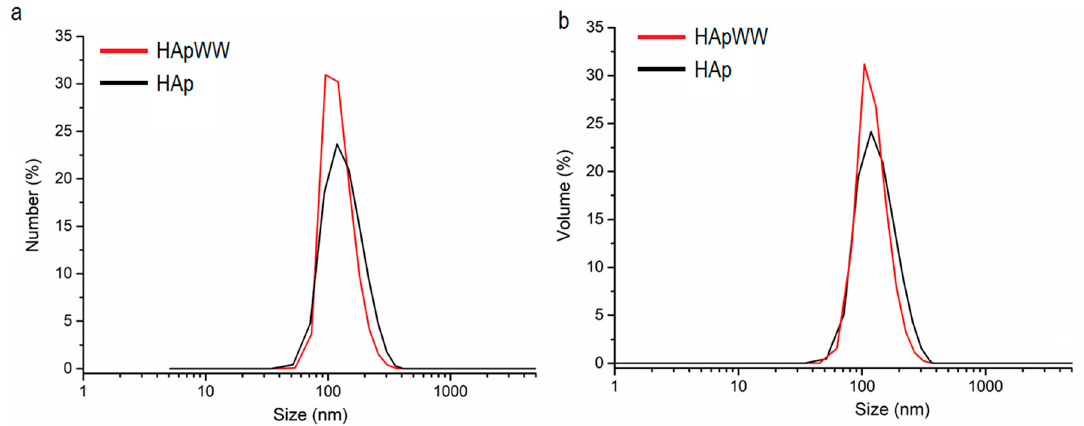
Figure 3. Dynamic light scattering (DLS) measurements of size dispersion of HAp (black) and HApWW (red) represent data weighted by number ( a ) and volume ( b ) of particles.